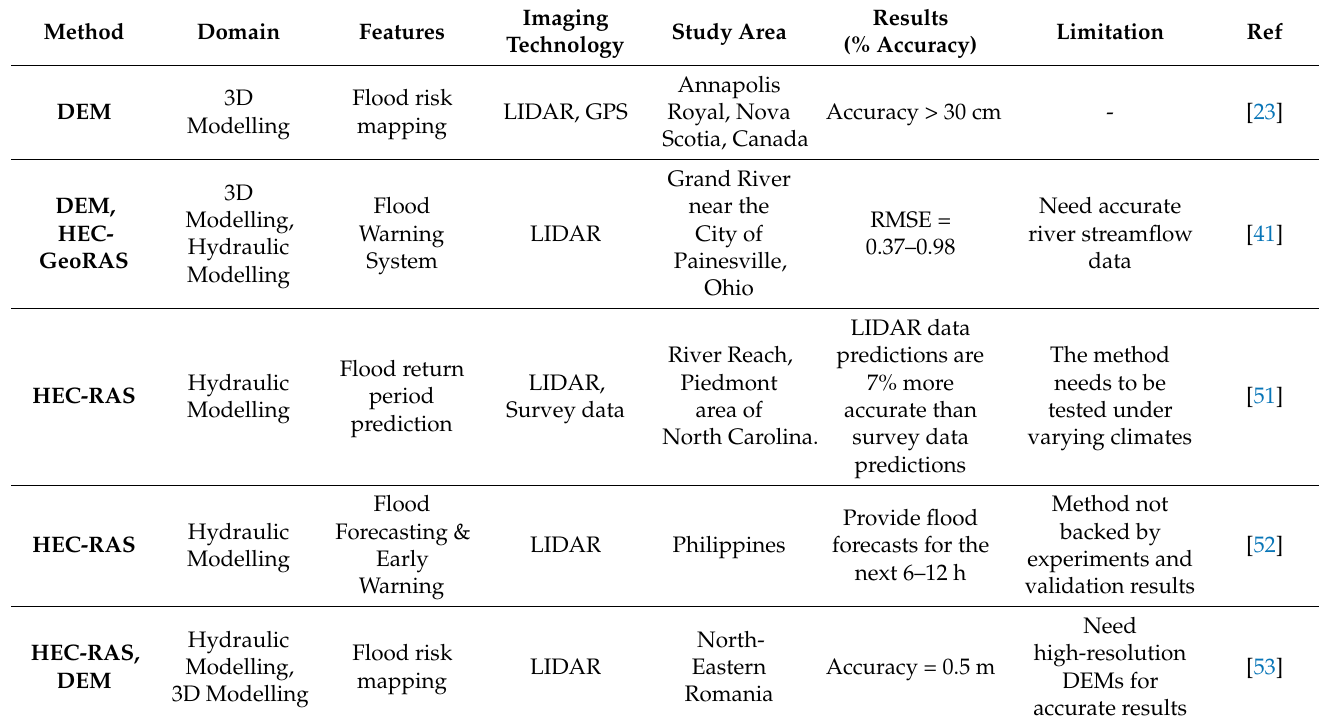
Table 3. LIDAR Technologies for Flood